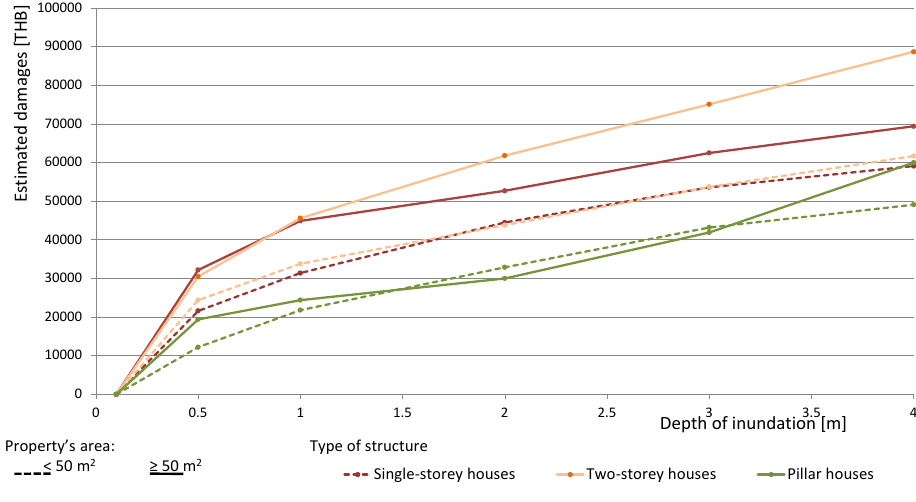
Figure 8. Depth-damage functions for Ayutthaya.